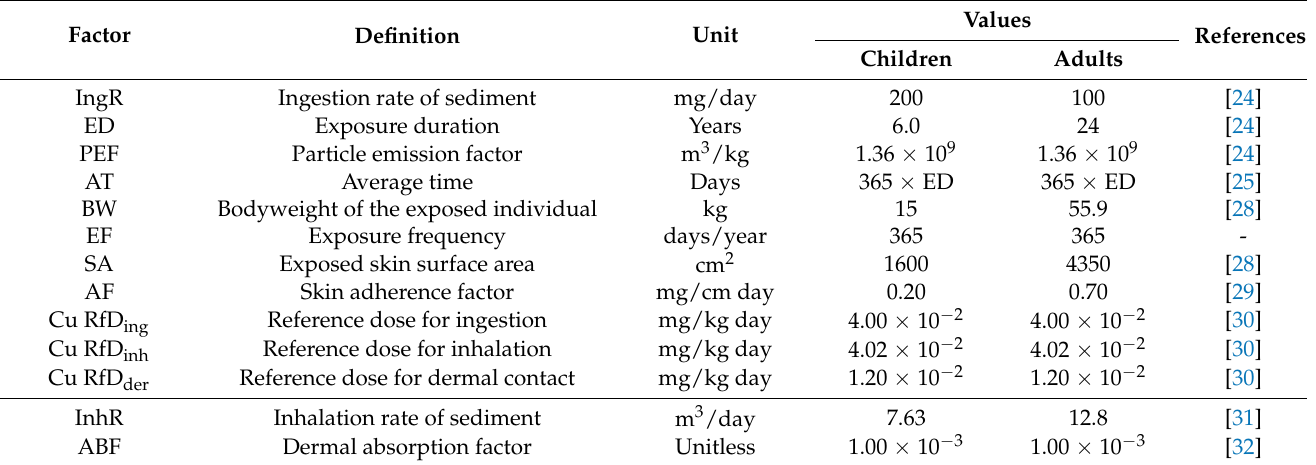
Table 1. Definition, exposure factors, and reference values used to estimate the intake values and health risks of potentially toxic metals in sediment for the present